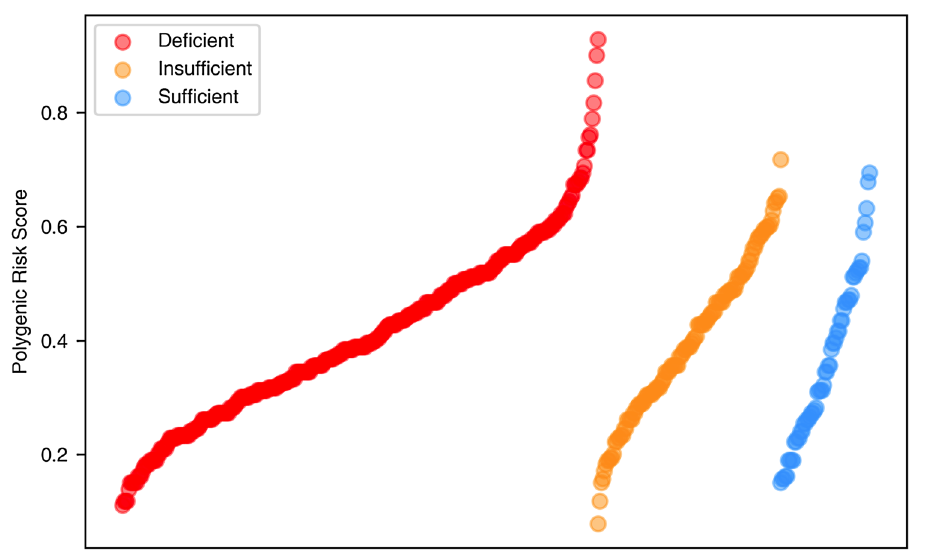
Figure 1. PRSs are represented as a continuous value. Patients were divided in three groups (Deficient—red; Insufficient—yellow; Sufficient—blue) considering its vitamin D level (a continuous variable). In each group, patients are sorted in ascending order of